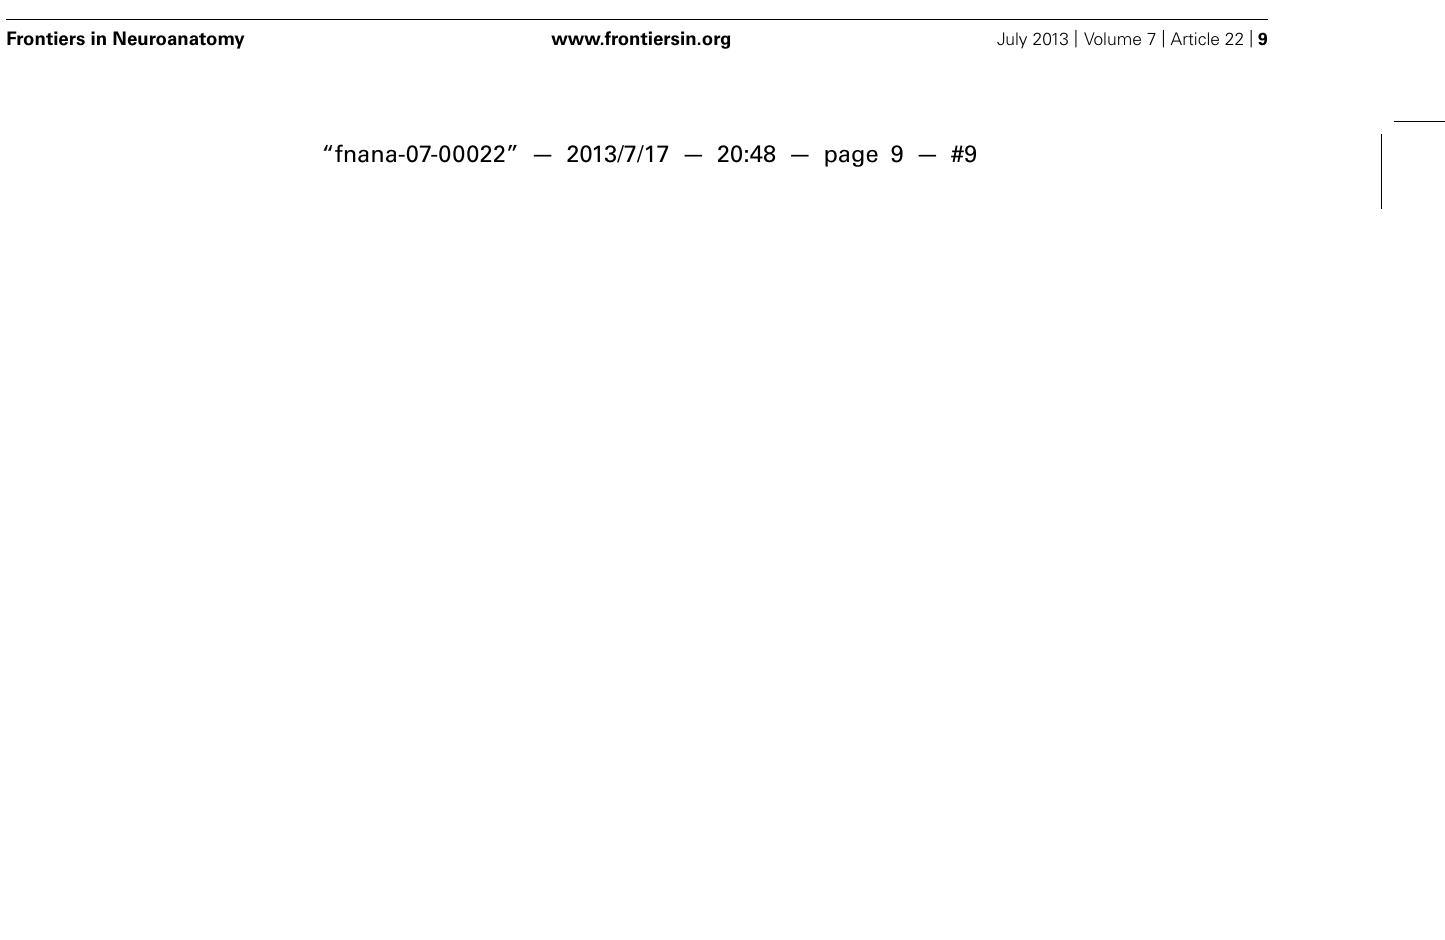
displaying a network of nodes (genes) connected by colored edges representing functional relationships. Interactions of these genes were identified based on the evidence indicated in the edges map. Unconnected genes were